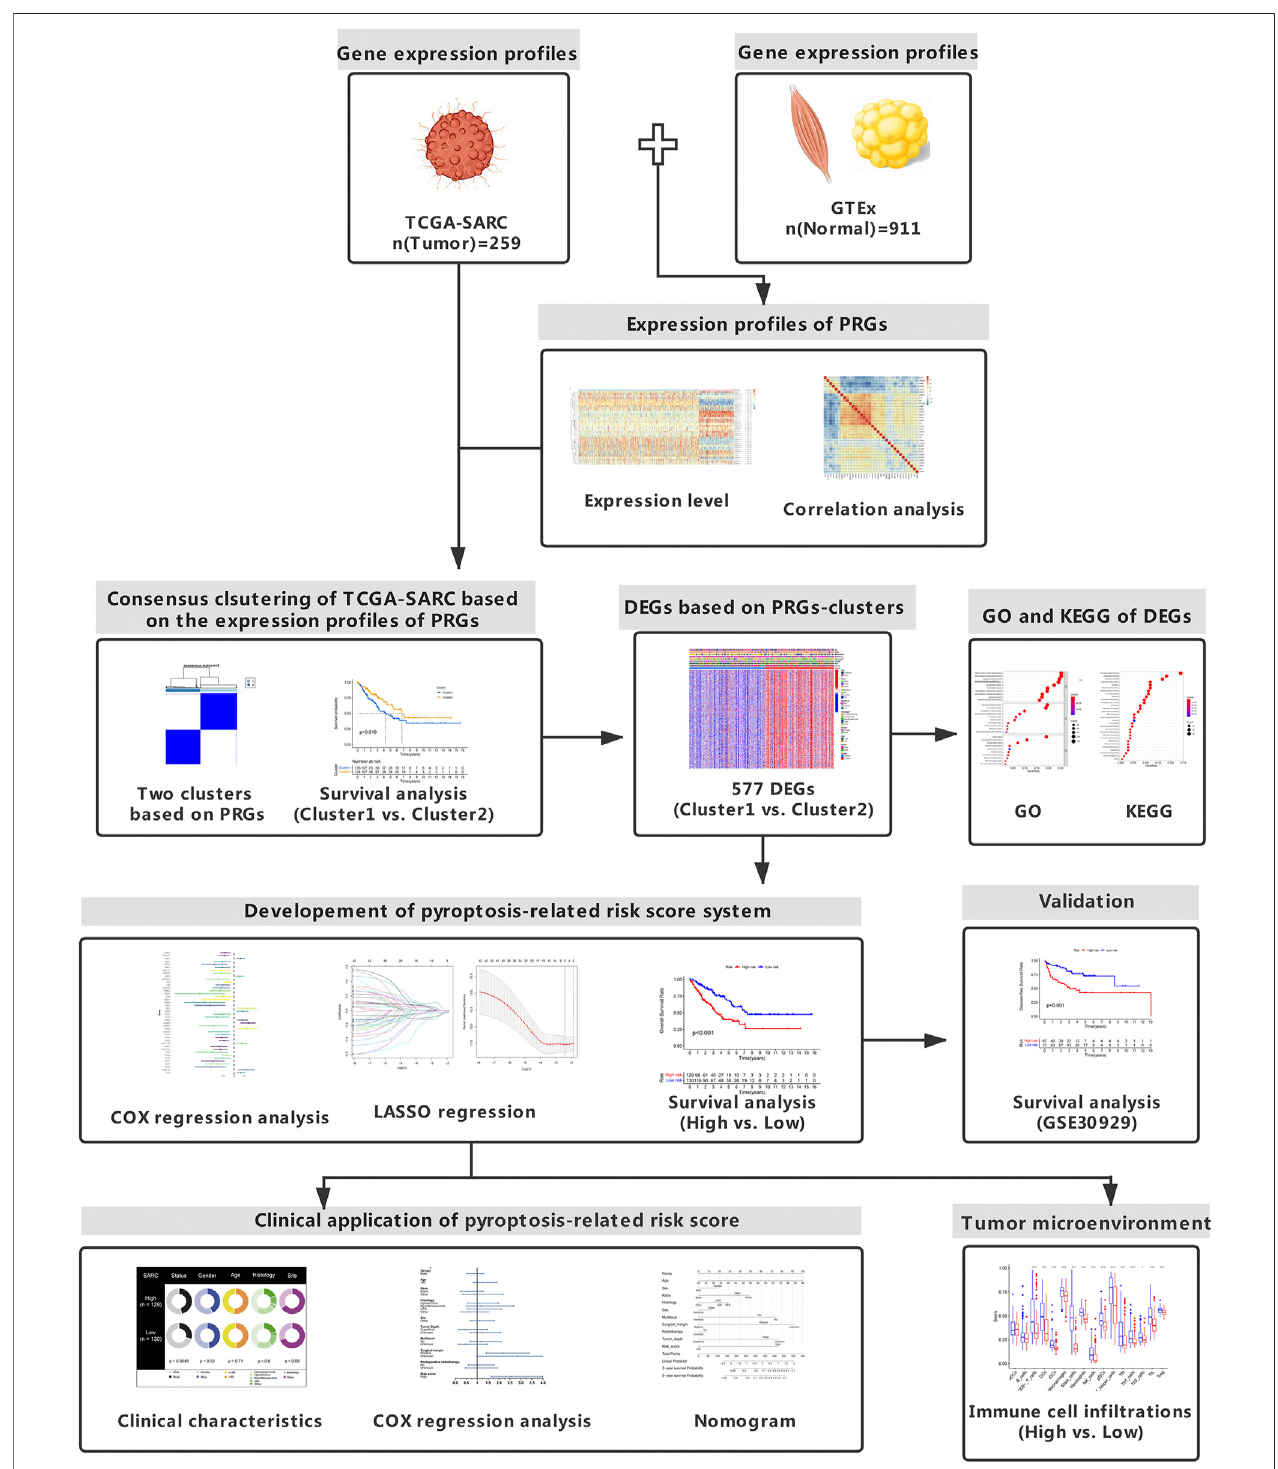
FIGURE 1 | Study design. The fl owchart presents the process of data collection and analysis.